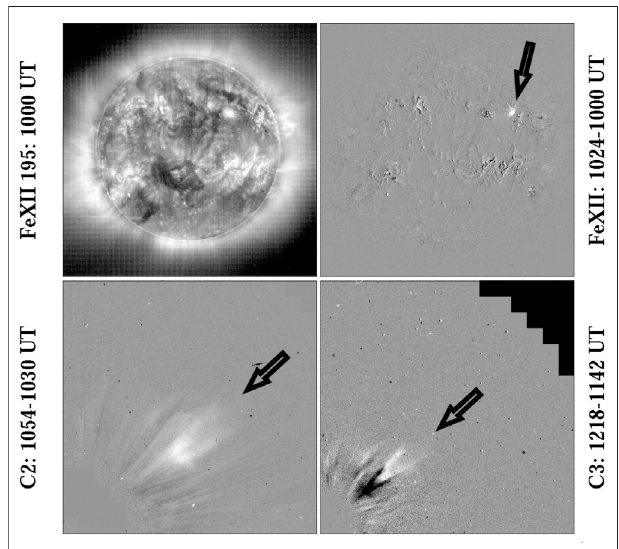
FIGURE 4 | Images of the impulsive SEP event of May 1, 2000 (see also Figure2 )are: upperleft afulldiskSOHO/EIT image at195 (cid:1) A before the fl are, upper right subtracted EIT image at 195 (cid:1) A with arrow showing new small white source in the NW quadrant, lower left subtracted image of NW quadrant of SOHO/LASCO/C2 coronagraph 2 – 6 R S with arrow showing narrowCME, lowerright subtracted NWquadrantofC3image4 – 30R S with arrow showing narrow CME (Kahler et al., 2001). Tracking and magnetic con fi guration for this event are shown by Nitta et al. (2006) and by Wang et al.